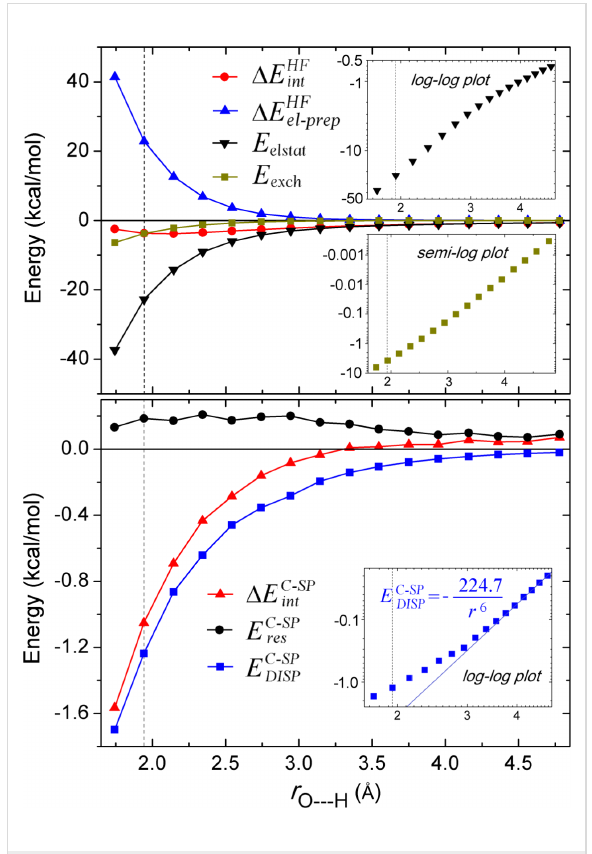
Figure 4: Decomposed HF energy terms (top), and correlation energy terms (bottom) of Conf1 of water dimer as a function of the H-bond dis- tance. The nearly linear relation of the long range electrostatic and London dispersion energy terms in the log–log scale as well as the exchange energies in the semi-log scale are given as inserts on the graphs. The black dotted vertical line at 1.943 Å corresponds to the equilibrium r e (O---H)